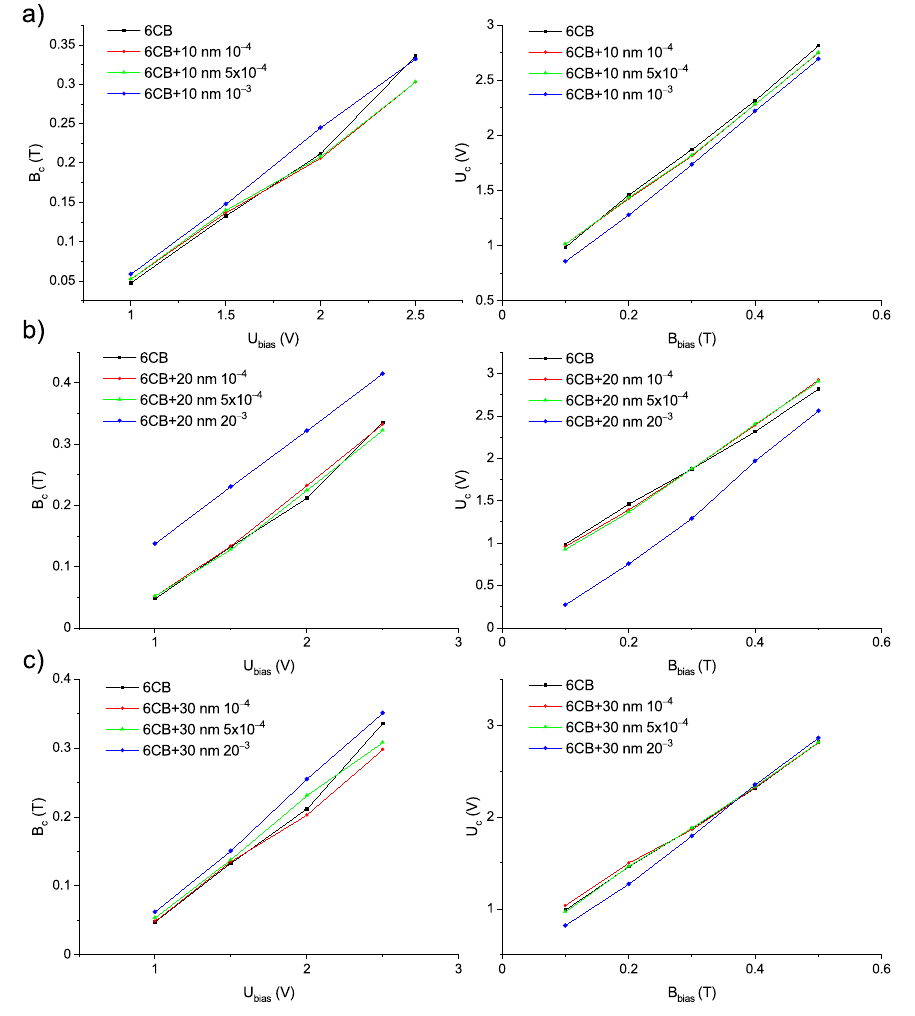
Figure 8. Experimental dependencies of threshold magnetic field B c on bias voltage U bias and threshold voltage U c on bias magnetic field B bias , respectively, for pure 6CB and composites containing ( a ) 10 nm ( b ) 20 nm ( c ) 30 nm particles obtained from curves shown in Figure 7.